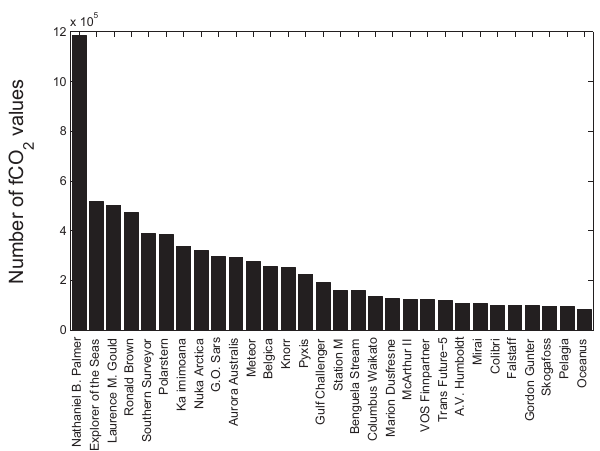
Figure 3. The number of surface water f CO 2 values obtained on the 30 ships, including 1 ship-based time series, hosting the most intense data collection e ff ort in SOCAT version 2.